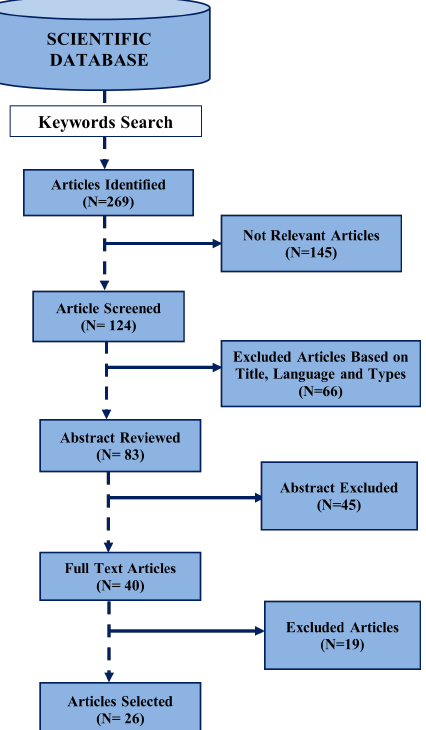
Figure 1. Criteria for Inclusion and Exclusion